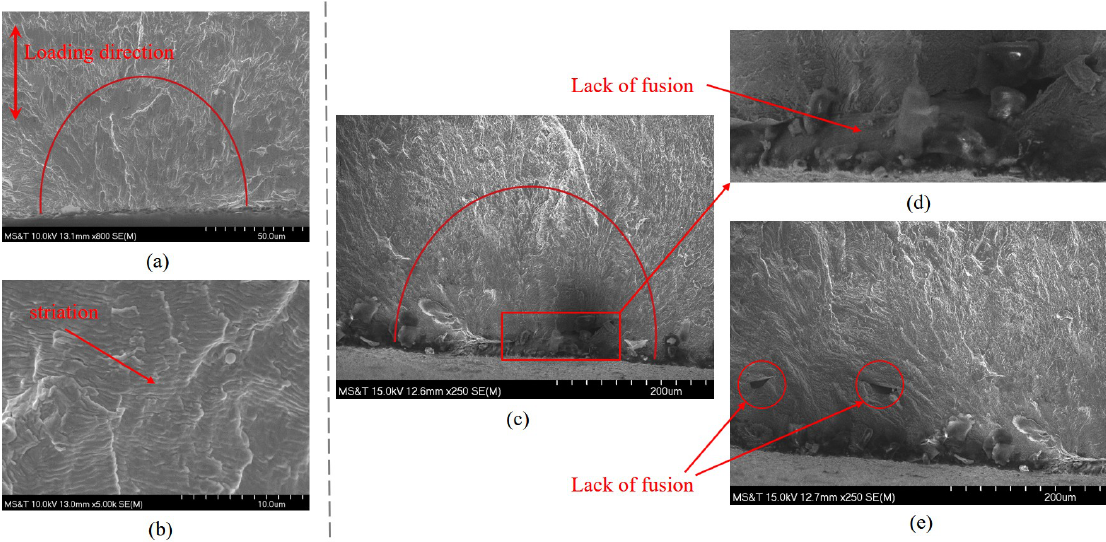
Figure 14. Fracture surface analysis of fine finished wrought and SLM fabricated materials, ( a ) crack nucleation site; and ( b ) crack propagation site of a wrought specimen, the nominal stress is 411.67 MPa; ( c ) crack nucleation site of SLM fabricated specimen, the nominal stress is 394.76 MPa; ( d ) presence of lack of fusion at the surface initiating the crack; ( e ) presence of lack of fusion within the volume enhancing crack propagation